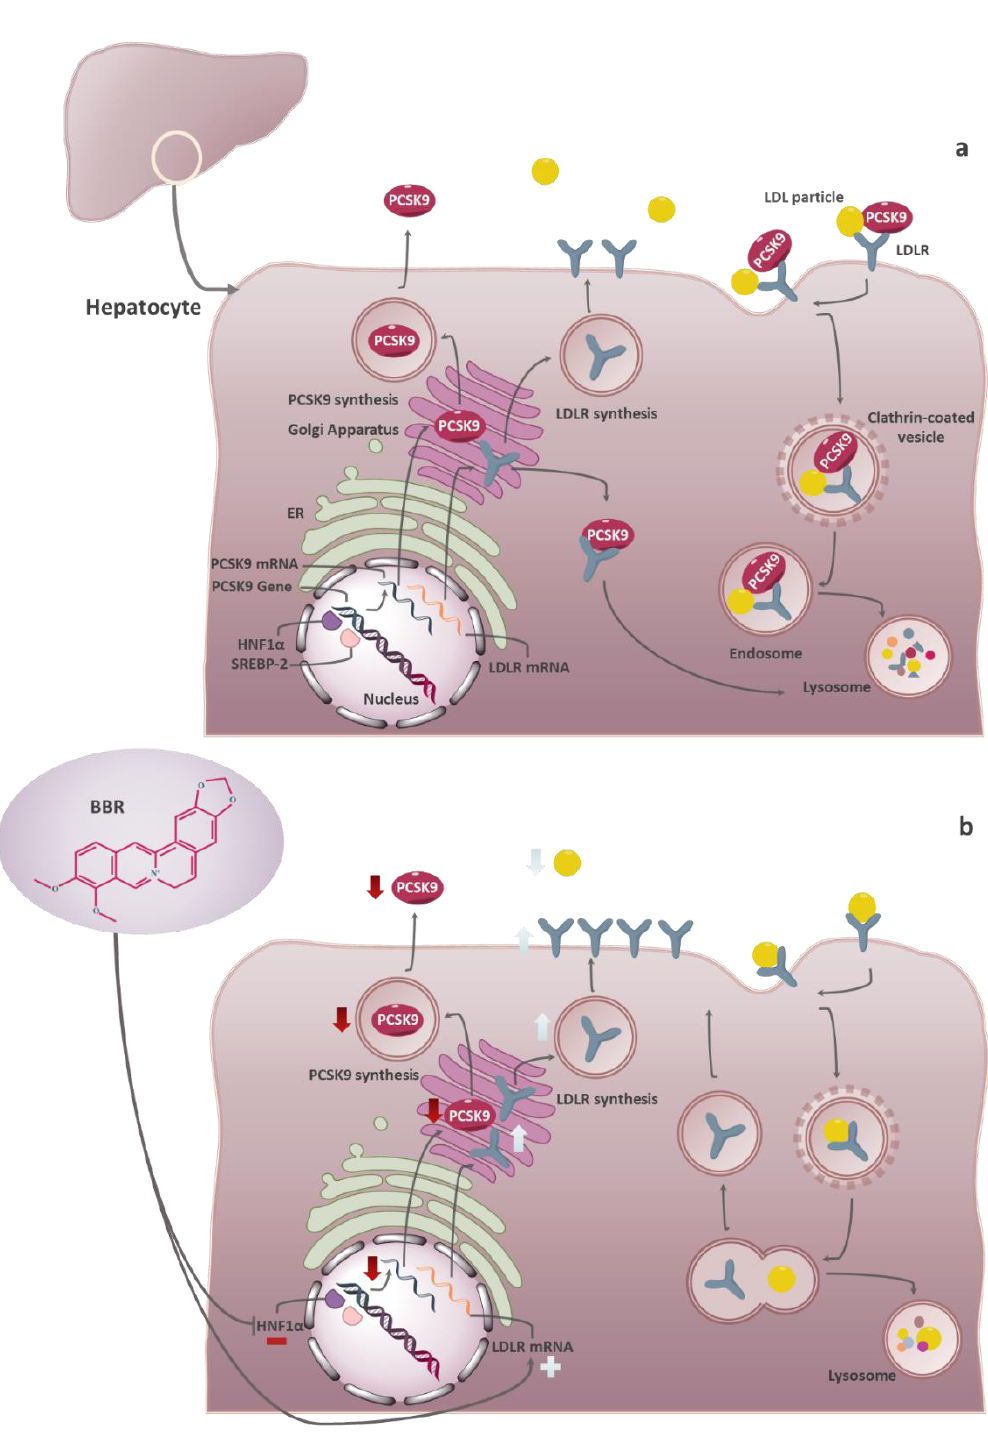
Figure 1: PCSK9 functions with or without presence of berberine. a. PCSK9 mechanism of action. PCSK9 is secreted from the endoplasmic reticulum to the Golgi apparatus and subsequently from the trans-Golgi network into the medium. A secreted form of PCSK9 binds to LDLR on the hepatocyte surface and facilitates degradation of the PCSK9-LDLR-LDL complex (extracellular pathway); PCSK9 directly binds to the newly generated LDLR in the trans-Golgi network, where the PCSK9-LDLR complex is directed to the lysosome (intracellular pathway). b. PCSK9 mechanism of action, in the presence of berberine. Berberine directly facilitates the stabilization of LDLR mRNA. It inhibits hepatocyte nuclear factor 1 alpha (HNF1α) protein, thereby decreasing PCSK9 expression, promoting the expression of LDLR, and limiting its degradation, resulting in more significant clearance of